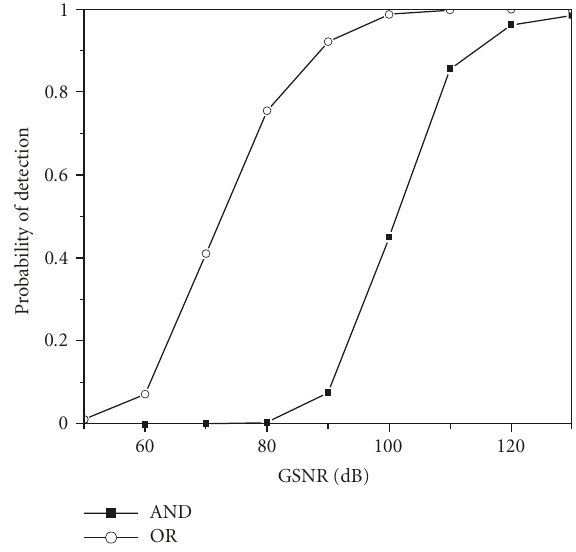
Figure 7: Probability of detection of two distributed CA CAC- FAR system in homogeneous Pearson background and in pres- ence of three interfering targets in one detector (GINR 1 = GINR 2 = GINR = 50 dB) adopting the “AND” and “OR” fusion rules. 3 N = 32, N = 16. P = 10 − 4 1 2 fa